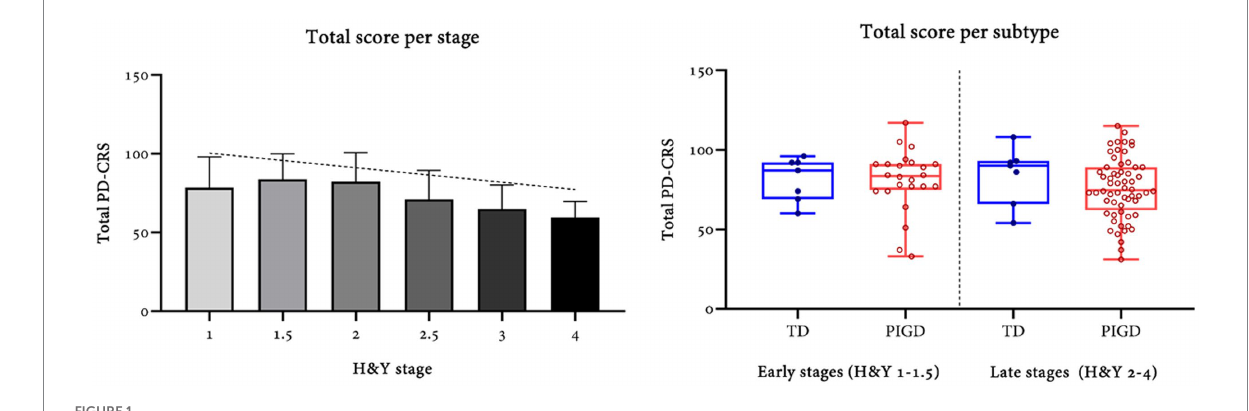
FIGURE 1 Total PD-CRS per MDS motor subtype and stage of disease according to the Hoehn and Yahr classification.